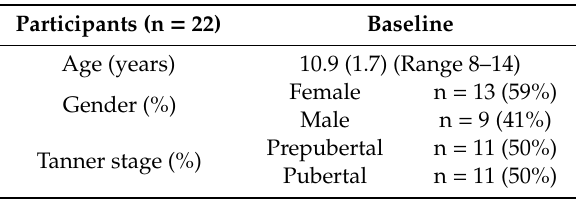
Table 1. Characteristics of the study